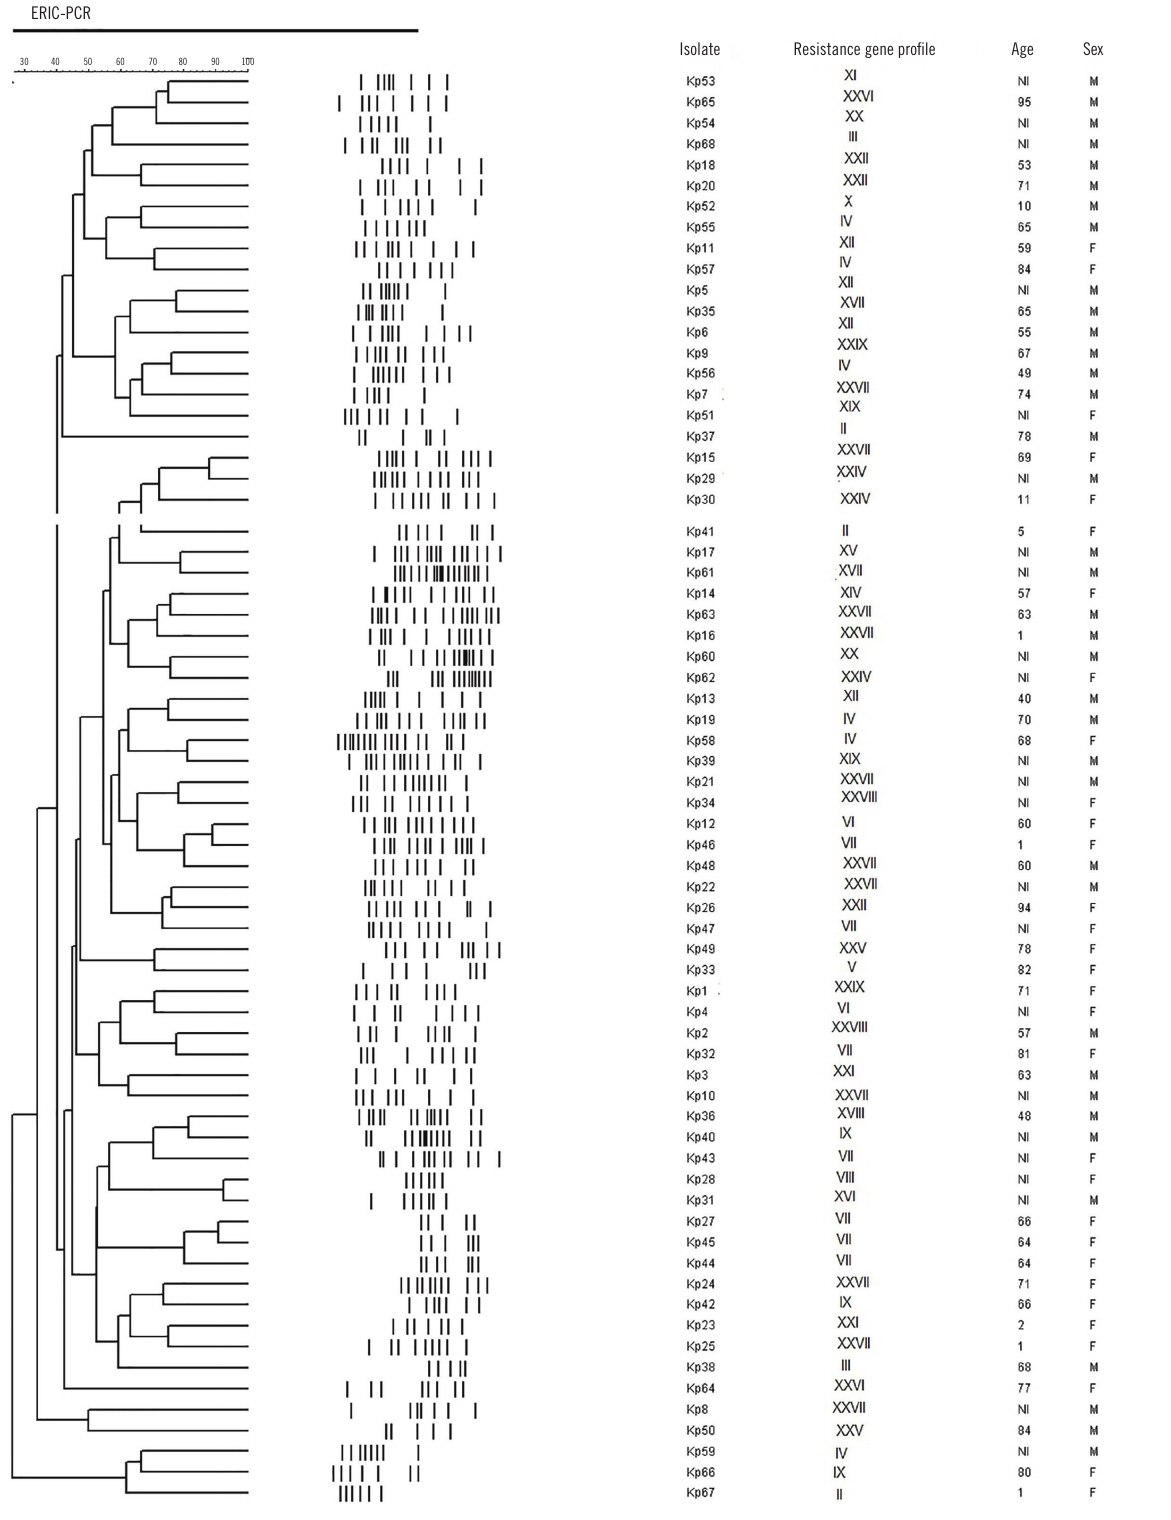
figurE 3 − Molecular typing of K. pneumoniae isolated by ERIC-PCR. The dendogram was built with the Bionumerics software 6.6 (Applied Maths) based on the Dice similarity coefficient and by means of the UP-GMA (27) ERIC-PCR: Enterobacterial Repetitive Intergenic Consensus-Polymerase Chain Reaction; UP-GMA: unweighted pair-group method with arithmetic averages; NI: not informed; F: female; M: